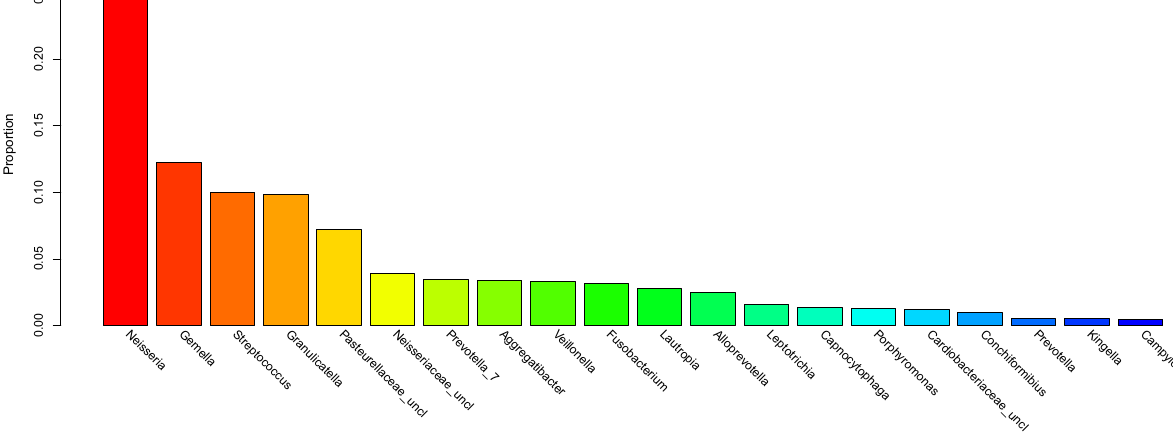
Figure 3. Overall rank abundance bar plot. The rank abundance plot illustrates the average abundance across all samples from the most abundant ( Neisseria ) to the least abundant ( Campylobacter ) across the top 20 taxa. The y-axis indicates the proportion of the taxa. The top 20 taxa represent 95.2% of the taxonomic